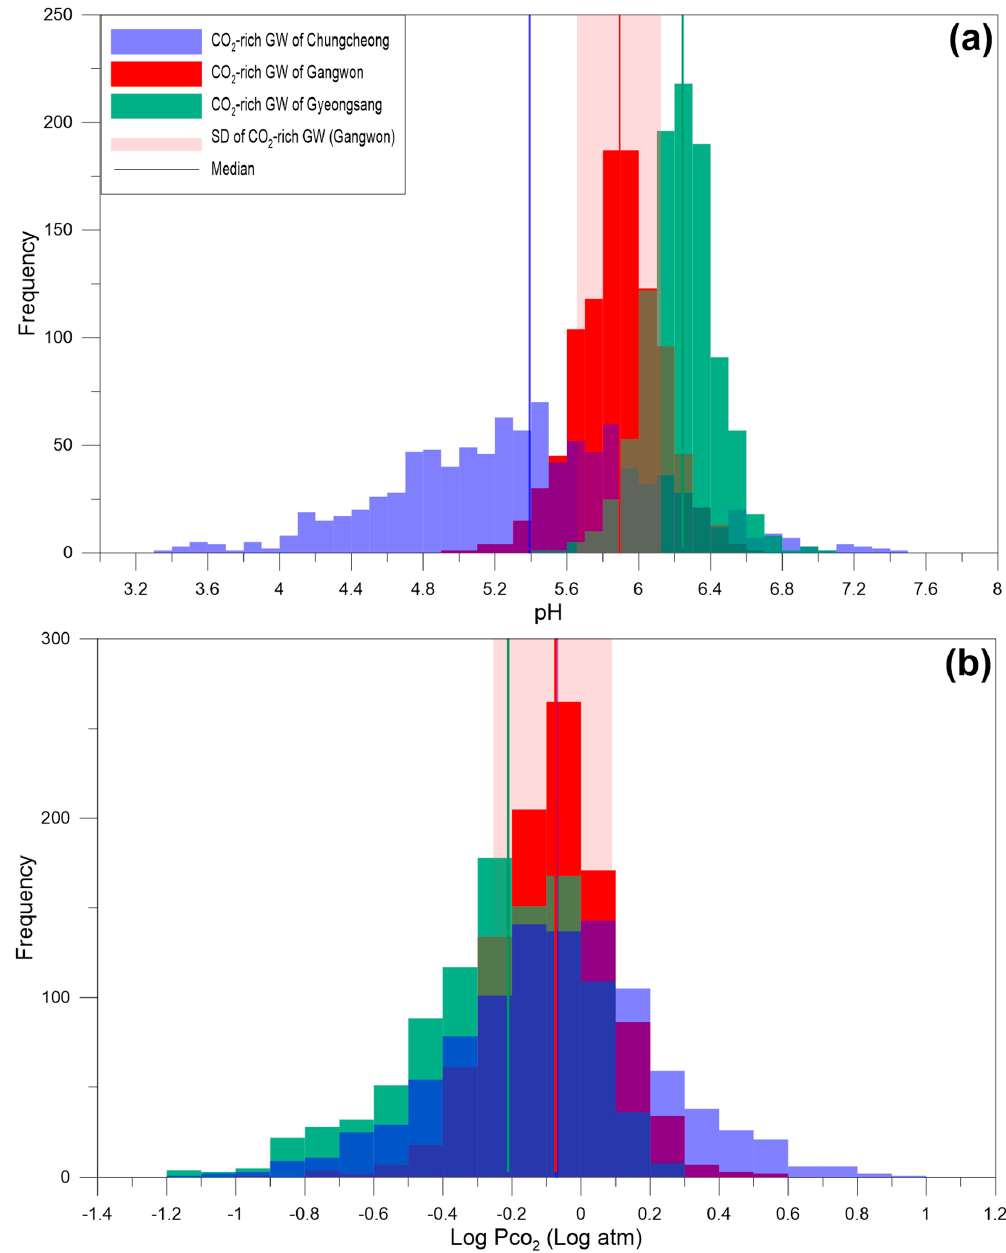
Figure 8. Comparison of Chungcheong (blue), Gyeongsang (green), and Gangwon (red) Provinces using probability density distributions of ( a ) pH and ( b ) P CO2 in CO 2 -rich groundwaters. The EC and TDS of the CO 2 -rich and ordinary groundwaters were such that Chungcheong < Gangwon < Gyeongsang and Gangwon < Chungcheong < Gyeongsang, respectively (Figure 9). This finding indicates that the chemical characteristics of the groundwaters are significantly affected by the geology. The different PDF distribution shapes appear as uniform for Gangwon and Gyeongsang Provinces and triangle-shaped for Chungcheong Province. The uniform shape indicates the similar density of the EC or TDS values in Gangwon and Gyeongsang Provinces while the triangle shape designates a great density at a certain range of EC or TDS values in Chungcheong Province. These